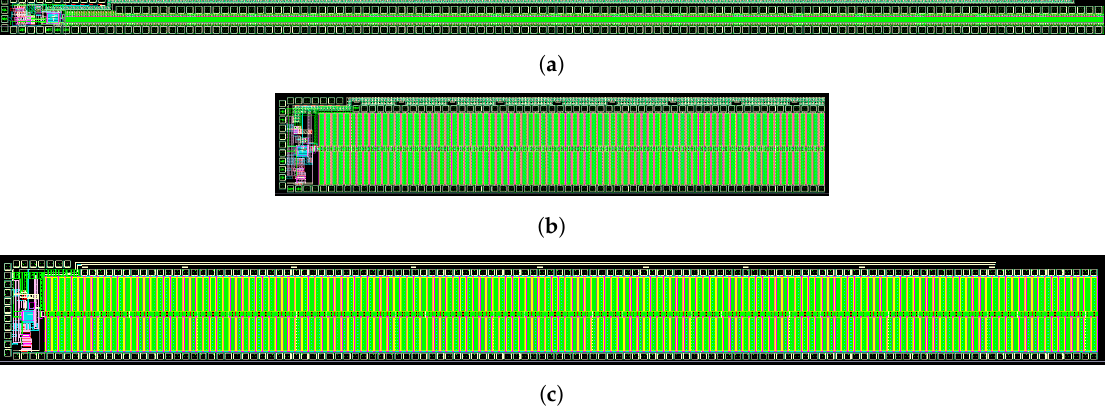
Figure 8. Layouts of the different version of the SOMBRA chip. ( a ) SOMBRA-LV10. LV switch for 10 A load current. On resistance: 1.6 m Ω . Total area: 9 mm 2 . ( b ) SOMBRA-HV05. HV switch for 5 A load current. On resistance: 7.6 m Ω . Total area: 13 mm 2 . ( c ) SOMBRA-HV10. HV switch for 10 A load current. On resistance: 3.8 m Ω . Total area: 25 mm 2 .